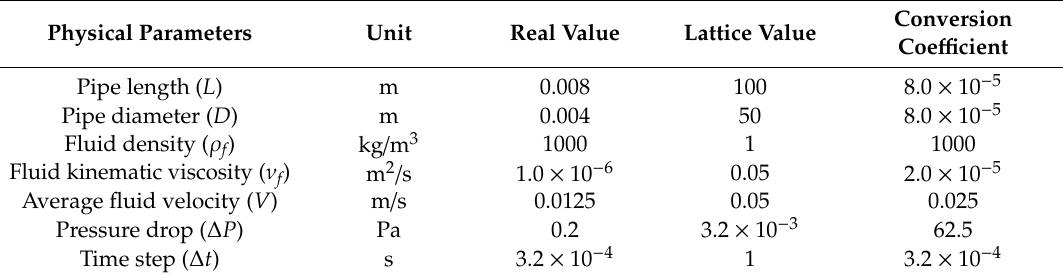
Table 1. Unit conversion of 3D pipe flow.